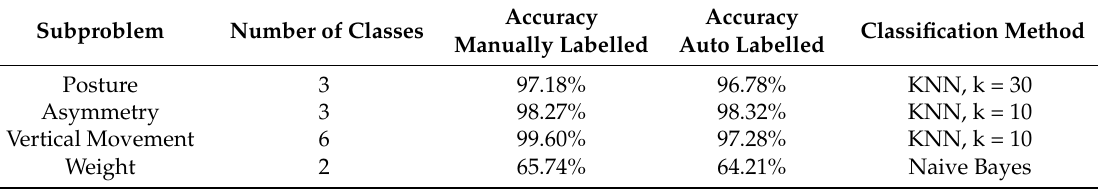
Table 8. Classification results for the 4 subproblems: posture, asymmetry, vertical movement, and weight. As the feature extraction process depended on the estimated start/end times, classification results for both automatically and manually labeled start/end times are